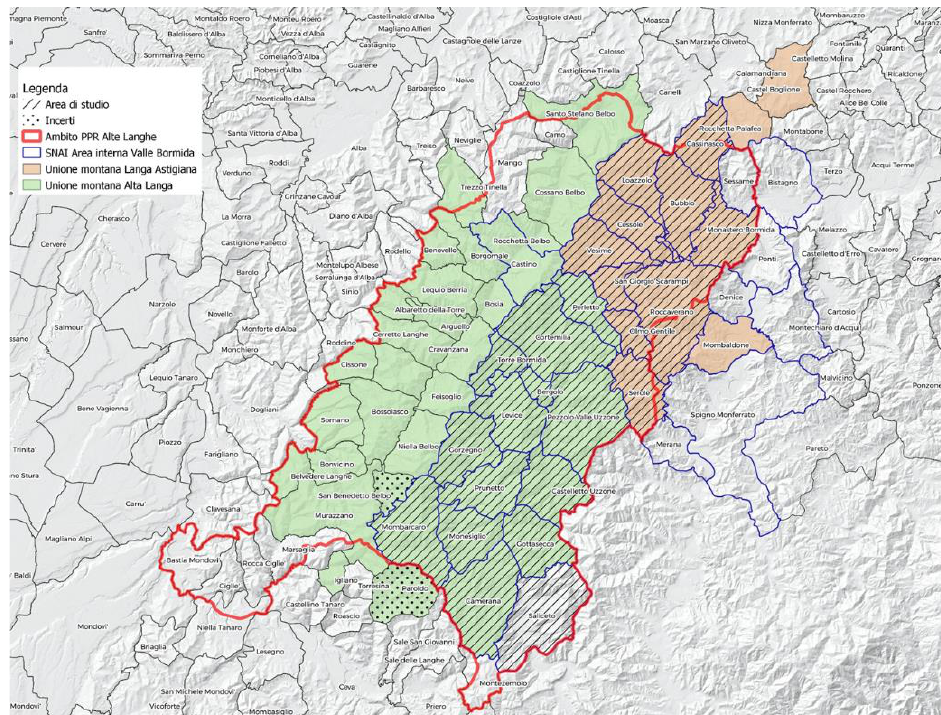
Figure 5. Upper Val Bormida Valley is part of the Alta Langa municipalities union (in green color); part of this area (the one with blue stripes) has been the object of a specific strategy for marginal areas. The red line identifies the specific area designed by the Regional Landscape Plan. The pilot research area here described corresponds to the blue striped area inside the red line. Legend: Area di studio: Study area; Incerti: Uncertain; Ambito PPR Alte Langhe: PPR Alte Langhe area; SNAI Area interna Valle Bormida: SNAI internal area of the Bormida Valley; Unione montana Langa Astigiana: Langa Astigiana mountain union; Unione montana Alte Langa: Alte Langa Mountain Union.